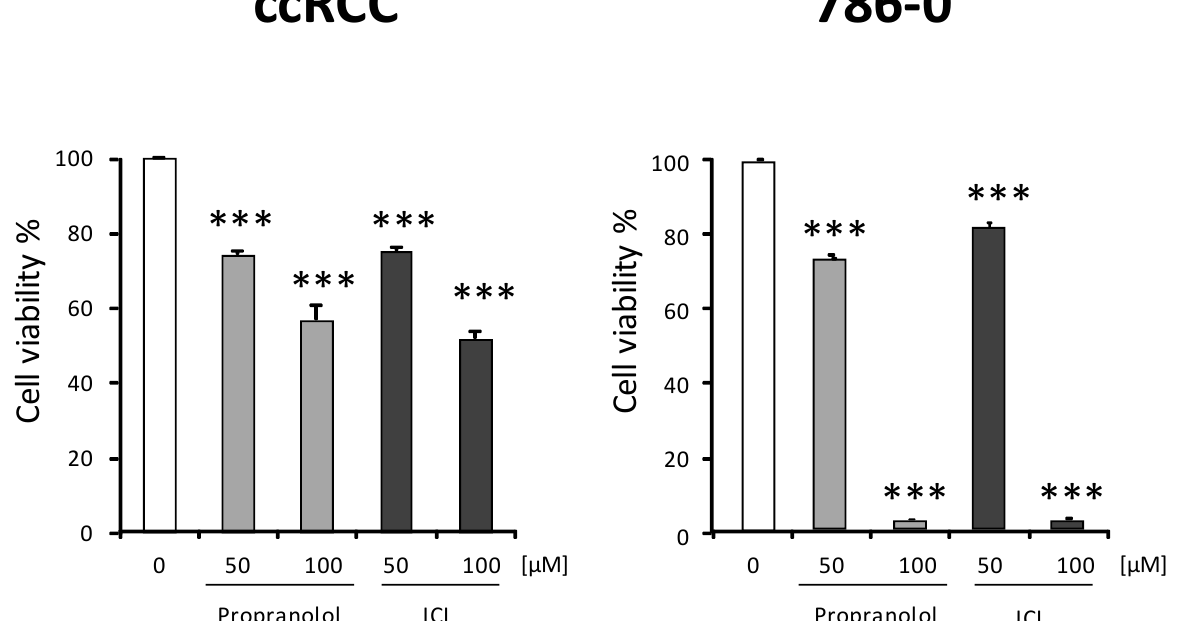
Figure 1. Representative cell viability of four primary VHL ccRCCs, and of 786-O cells after [0, 50, or 100 µM] propranolol or ICI-118,551 treatment for 48 h. In Figure 1, as previously reported [2], the ADRB2 antagonists propranolol and ICI dose-dependently decrease cell viability. Here, only two relevant doses of the ADRB2 antagonists (50 and 100 µ M) were used in accordance with our previous experience [2]. Primary cultures from VHL patients proved more resistant to ADRB2 blockade than the 786-O cell line. Therefore, to obtain an equal number of cells, throughout the following experiments the VHL-ccRCC primary cultures of VHL-ccRCC were incubated with 100 µ M of both β 2-blockers, while 786-O was treated with only 50 µ M. All data are based on three independent experiments for each of the four primary ccRCCs and for the 786-O cells. Error bars denote ± SEM. Student’s t -test: *** p < 0.001.